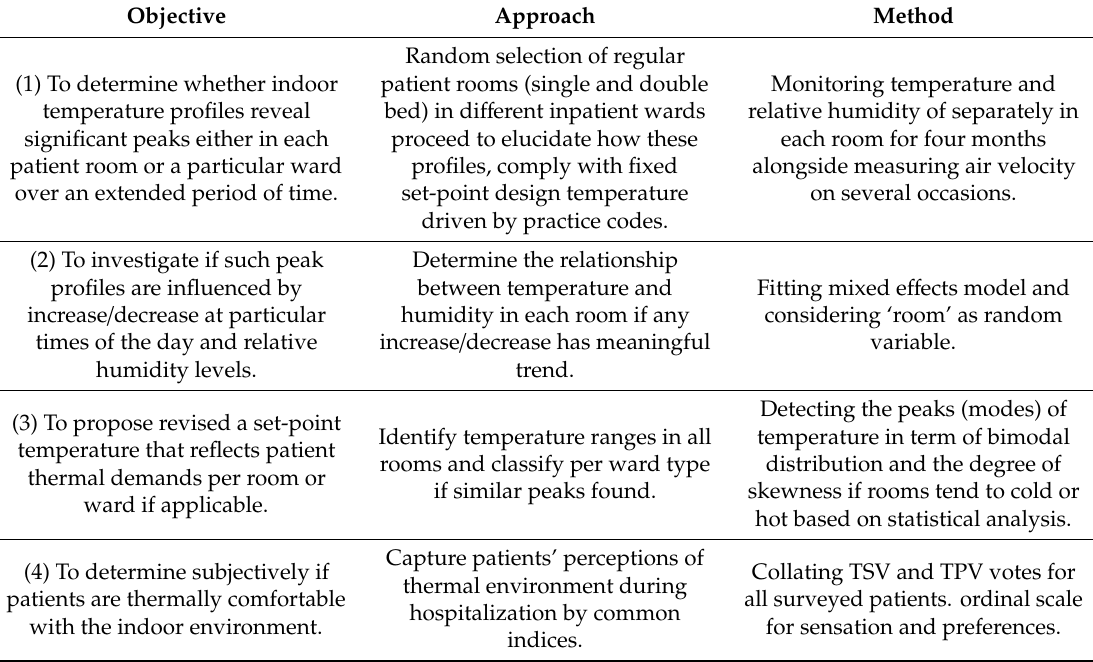
Table 1. Research objectives, approaches, and methods (methods are detailed in Section